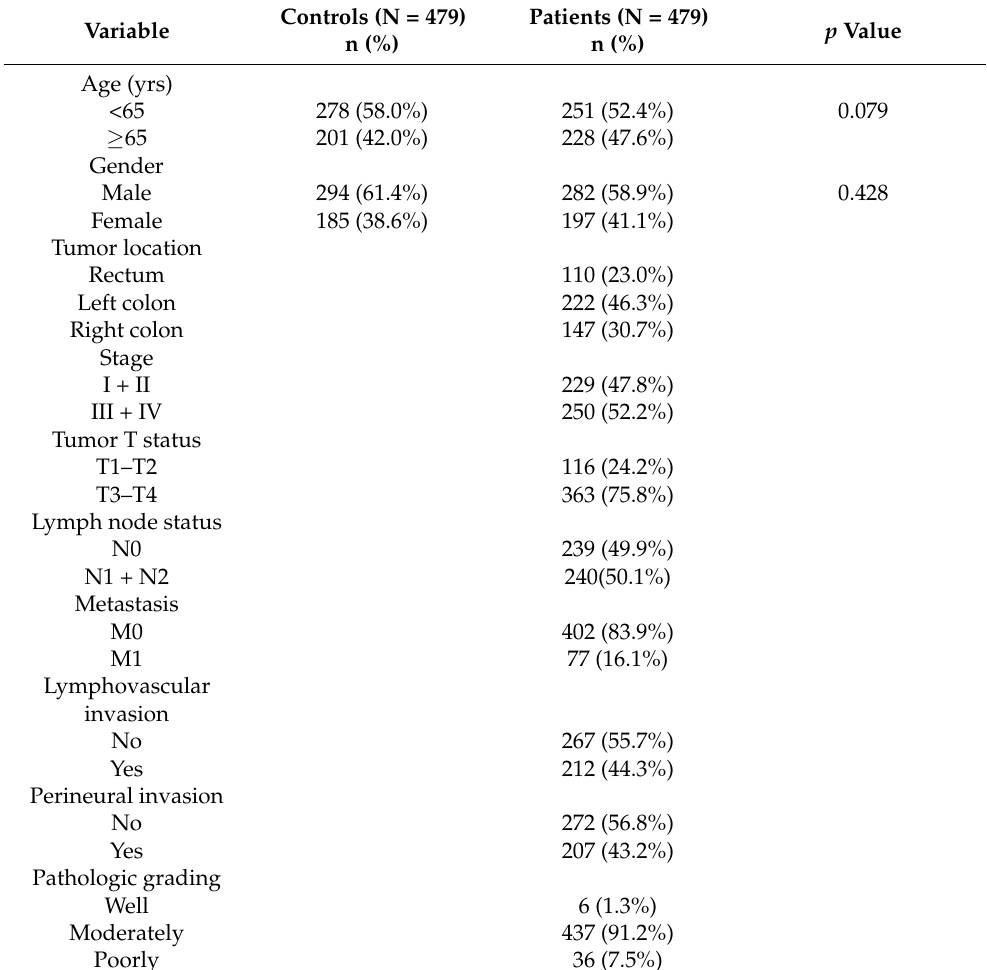
Table 1. The distributions of demographical and clinical characteristics in 479 controls and 479 patients with